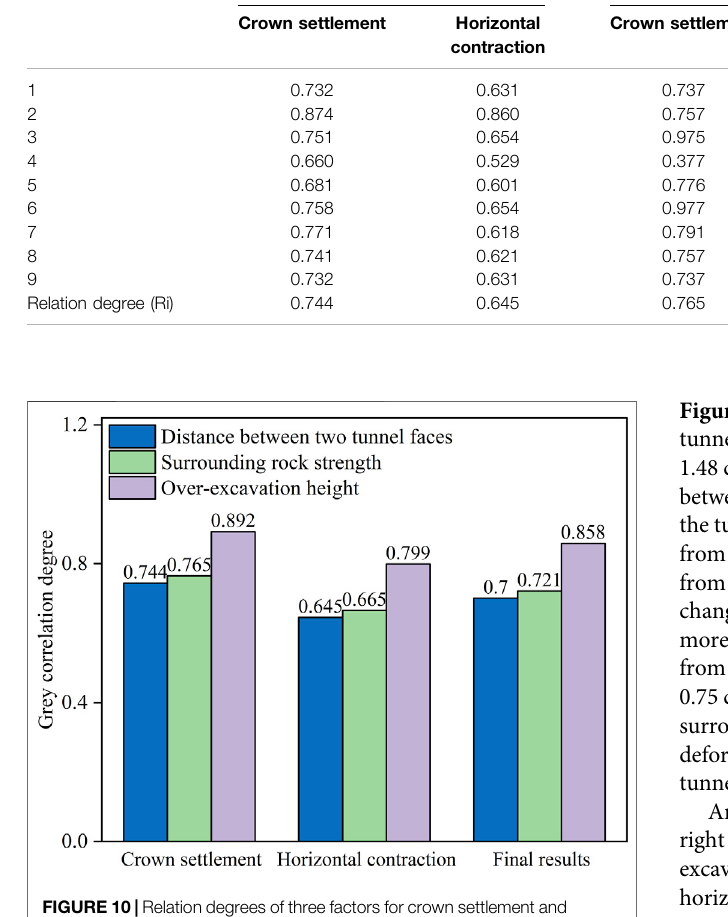
FIGURE 10 | Relation degrees of three factors for crown settlement and horizontal contraction and fi nal results.